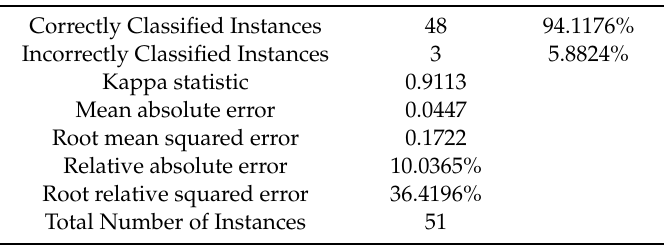
Table 1. Stratified cross-validation.